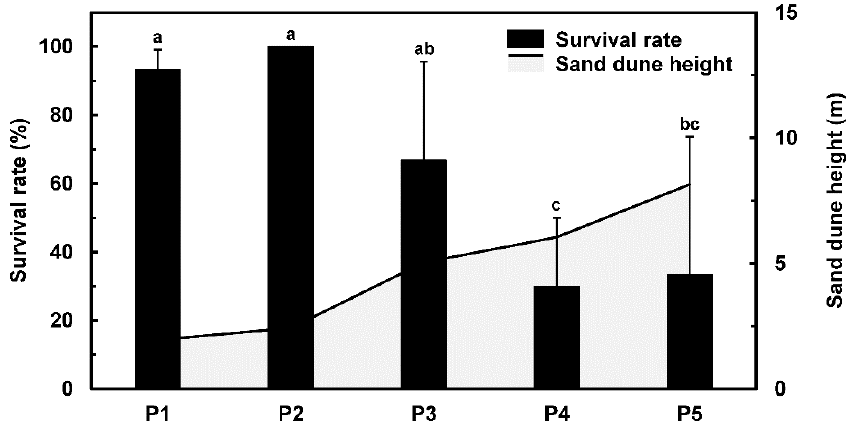
Figure 3. Survival rate of Mongolian pines planted for nine growing seasons according to changes in sand dune height. Values with different small letters denote significant differences among five measurement points (Jonckheere–Terpstra test, p ≤ 0.05).